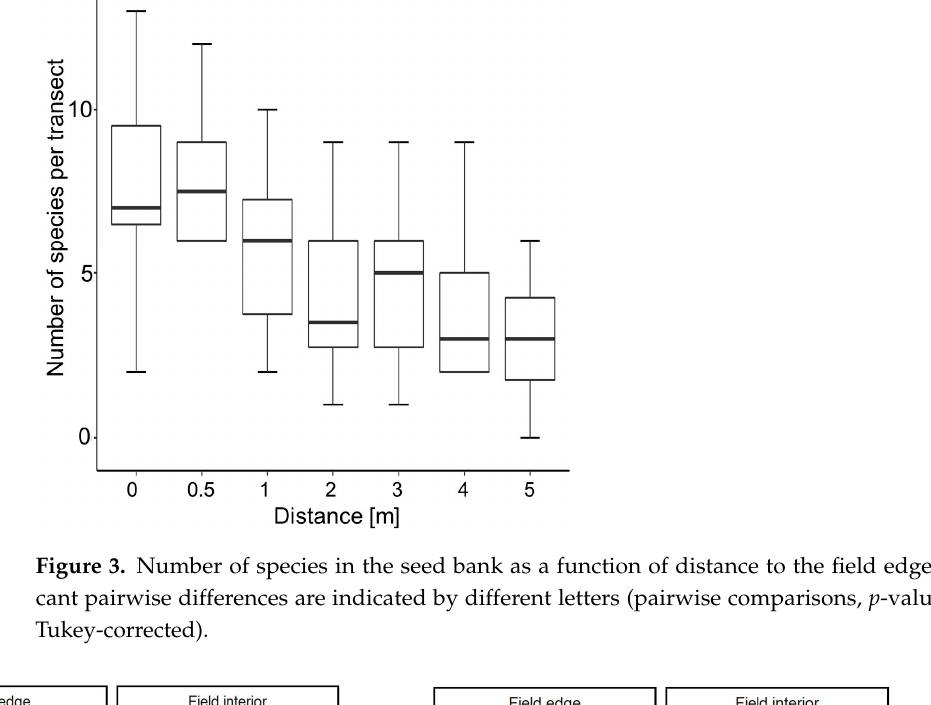
Table 1. E ff ects of soil depth, fi eld position, and tillage regime on seed and species number assessed with linear mixed models (ANOVA). Sum Sq: sum of squares; Num DF: number of degrees of free- dom, Den DF: denominator degrees of freedom; F: F-value; p : probability value.